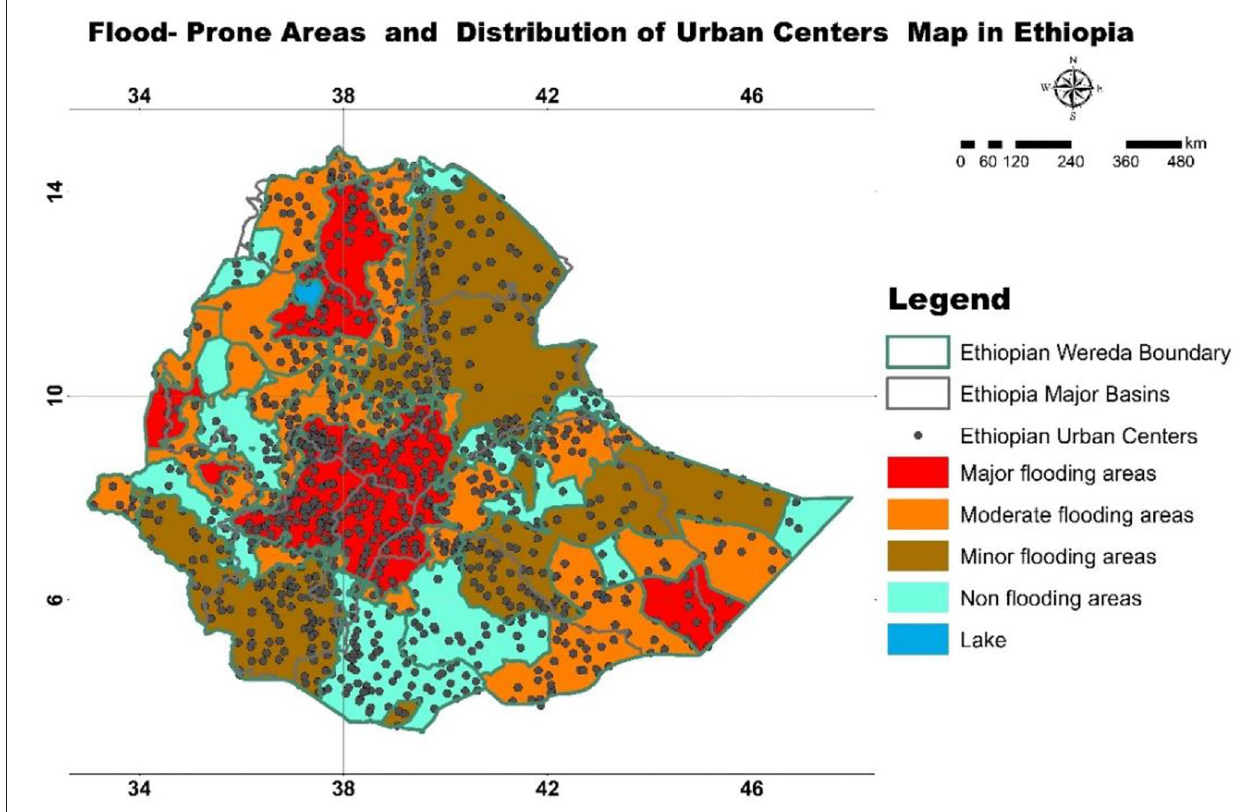
FIGURE 8 | Flood-prone areas in Ethiopia. Source: Adopted from Ethiopian Development Research Institute/Global Green Growth Institute (EDRI/GGGI) (2015).